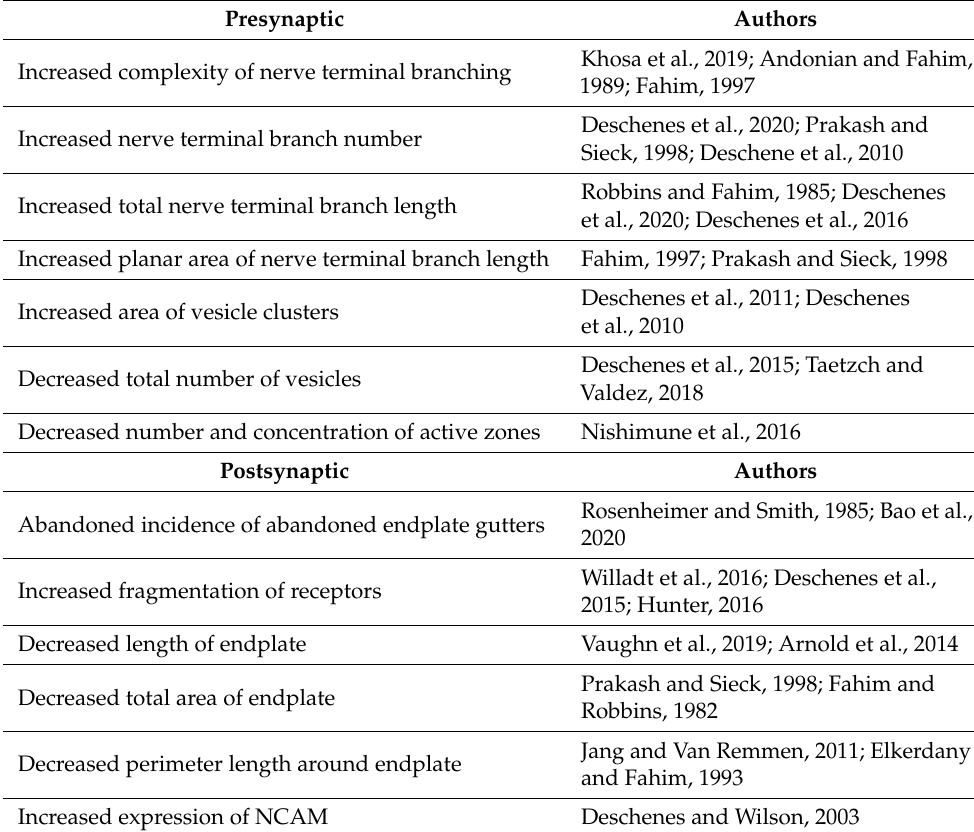
Table 1. Morphological Adaptations of the NMJ to